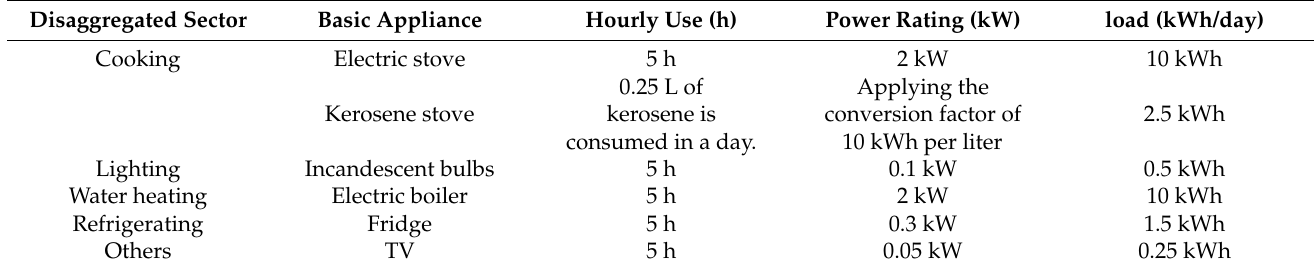
Table 12. Results of the survey on typology A informal house.